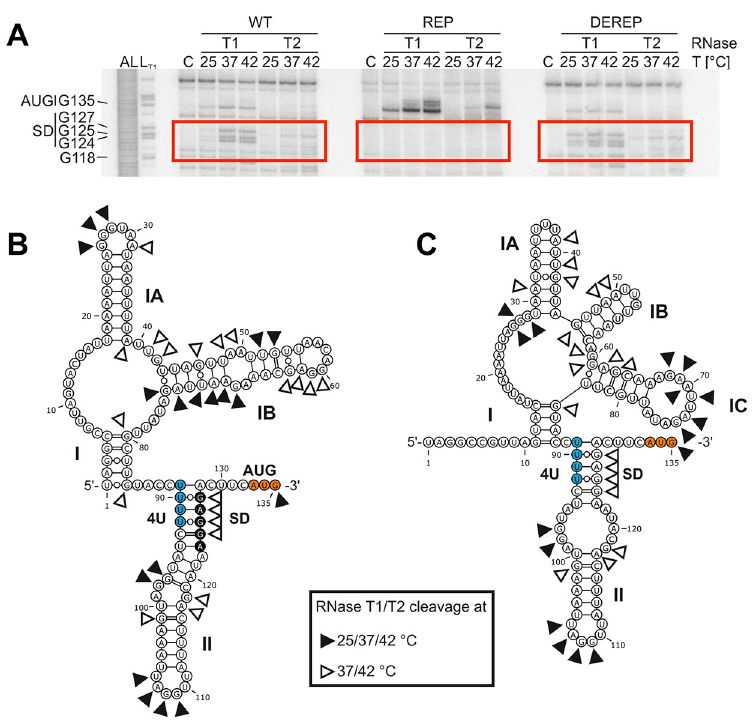
Fig 3. The tviA 5’ UTR fourU RNA thermosensor facilitates temperature-dependent access to the SD sequence. A) 5’ end-labeled in vitro transcribed RNA containing the wildtype tviA 5’ UTR (WT), the rep3 (T90,92C) tviA 5’ UTR mutant (REP), or the derep4 (T89,91G;C93G) tviA 5’ UTR mutant (DEREP) was enzymatically probed with RNases T1 (cuts 3’ of single-stranded guanines) and T2 (cuts 3’ of single-stranded nucleotides with preference order: A > C > U > G) at 25, 37, and 42˚C. Fragmented RNA was separated on an 8% polyacrylamide gel, a portion of which is shown here. AL: alkaline ladder. L T1 : RNase T1 cleavage in sequence buffer at 37˚C. C: RNA treated with water instead of RNase at 42˚C. B) Secondary structure of the tviA 5’ UTR predicted by Mfold [36]. Cleavage sites of RNase T1 and T2, the fourU RNA thermosensor (4U), the Shine-Dalgarno (SD) sequence, and the start codon (AUG) are indicated. C) Secondary structure of the tviA 5’ UTR predicted by Mfold using cleavage information as constraints for folding. Secondary structures were visualized using VARNA applet 3.93 [45]. Data shown in A are representative of 4 independent experiments. See also S4 Fig.